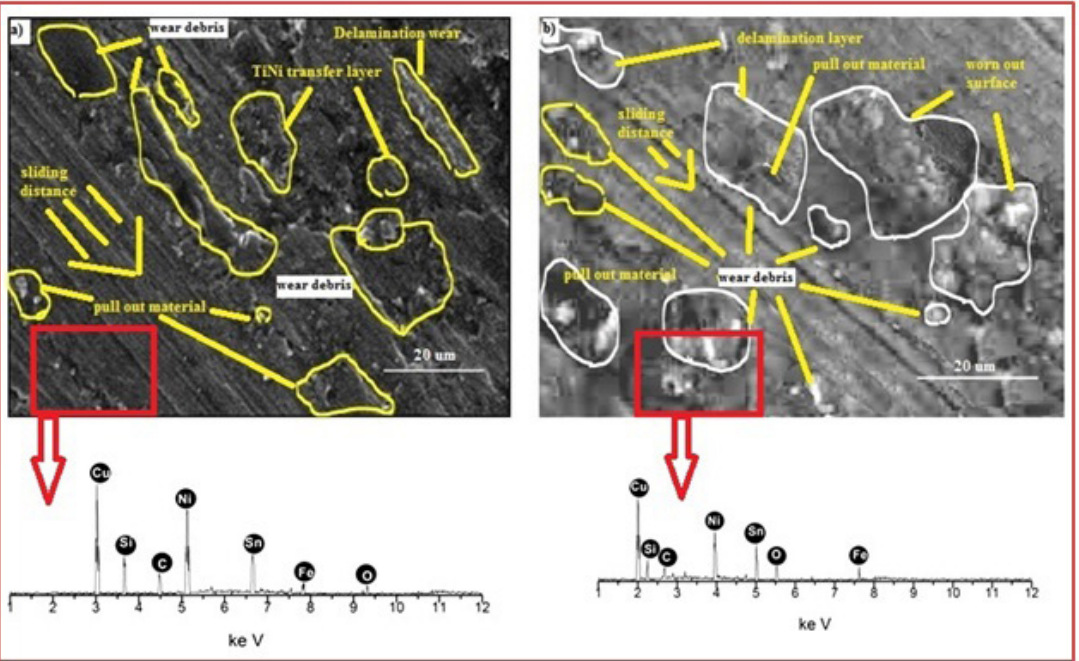
Figure 13. SEM micrograph of worn surface of Nitinol composite a) prepared at minimum sintering time b) prepared at maximum sintering